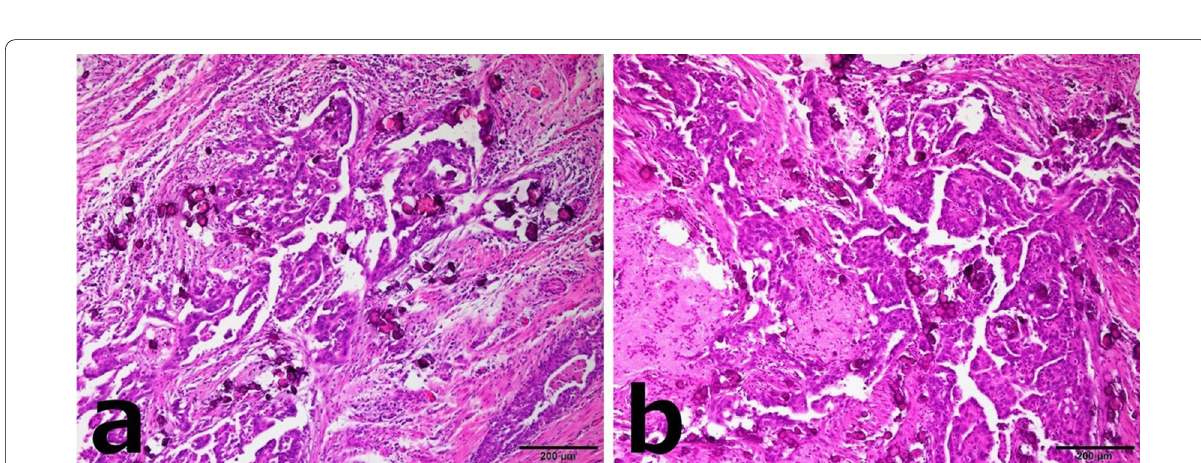
cancer, tumor reduction surgery was performed (Fig. 8a, b). After surgery, six courses of docetaxel atin chemotherapy were performed as adjuvant